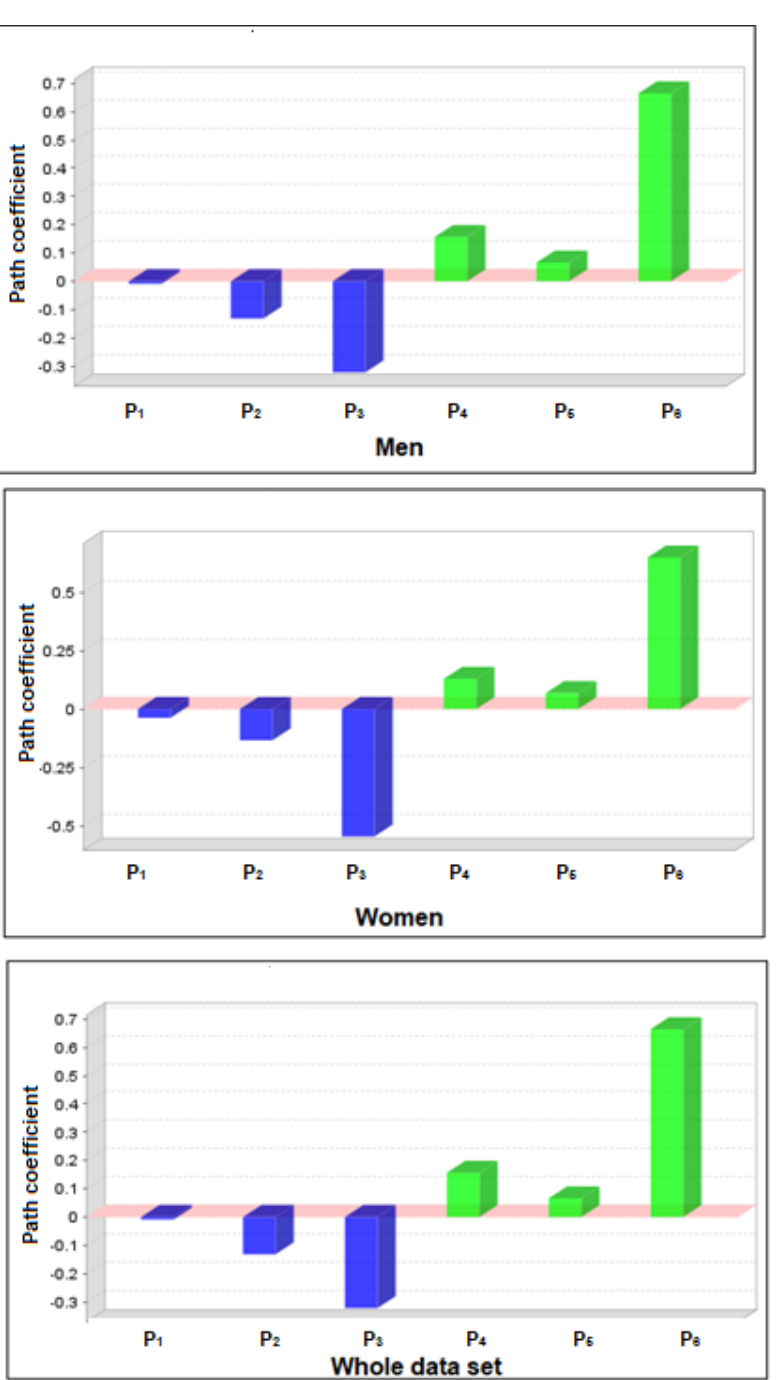
Figure 4. Path coefficients amongst variables for each gender group and the whole data set. P 1 = Anxiety-GNSS; P 2 = Anxiety-Navigation; P 3 = Age-GNSS; P 4 = GNSS-Navigation; P 5 = Estimation- GNSS; P 6 = Estimation-Navigation.